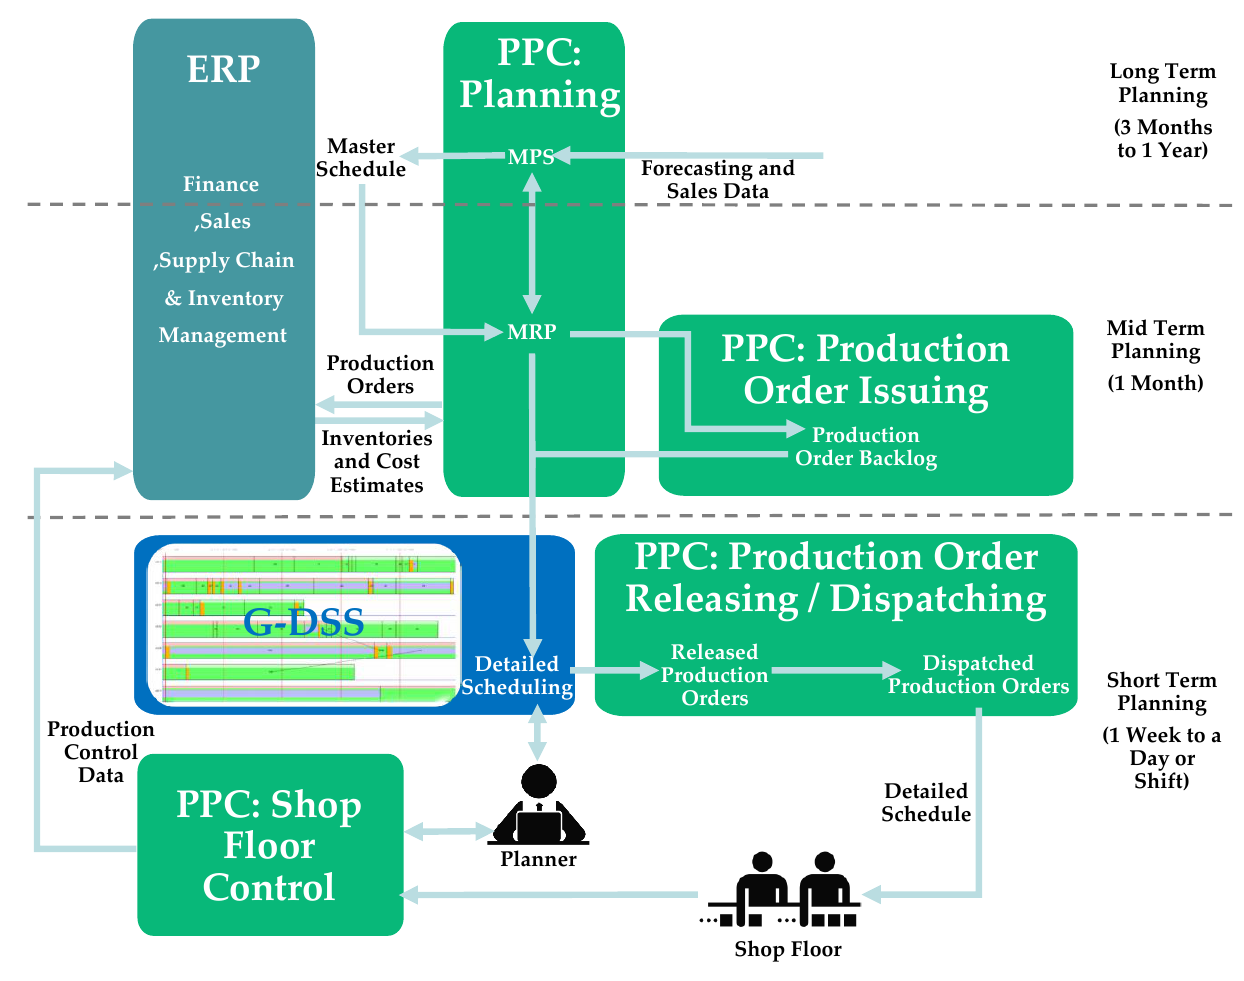
Figure 3. The G-DSS ’ s framework. Figure 3. The G-DSS’s